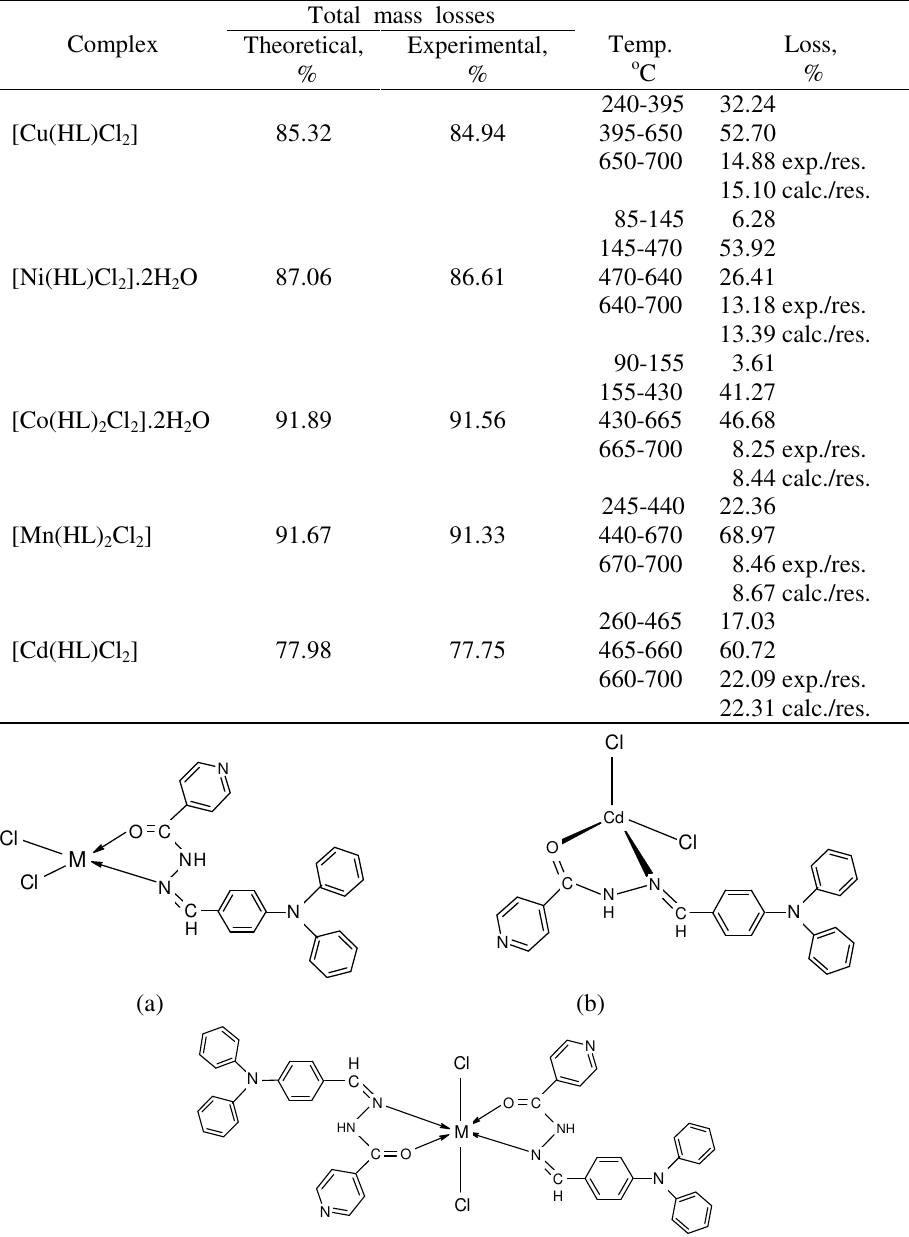
Table 4. Thermal analysis for the complex combinations.